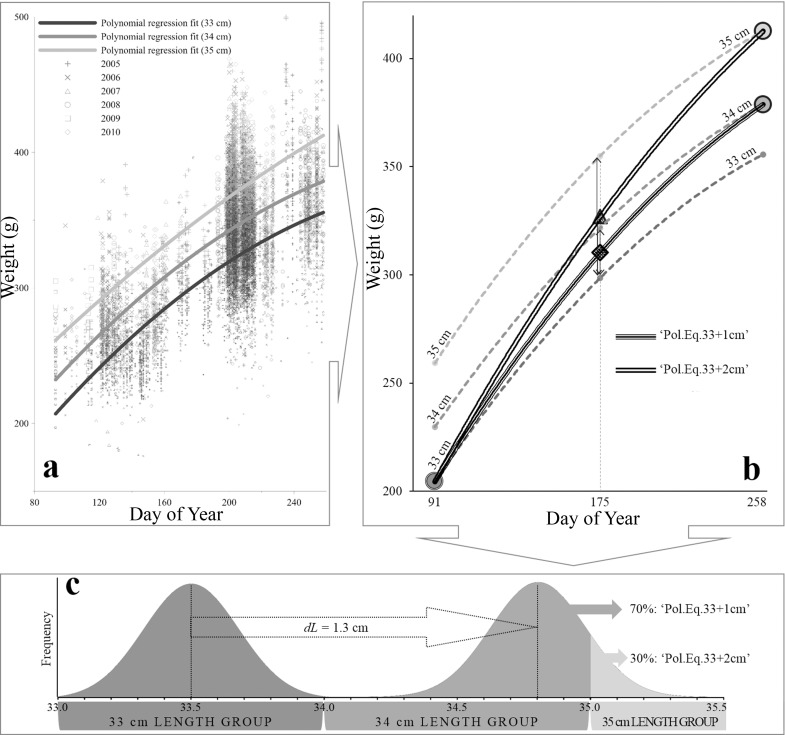
Example of growth correction for length distribution of herring, considering 33 cm length group as reference and a dL value of 1.3 cm (as a result example for Eq 6).Firstly, (a) polynomial equations are fitted for weight (g) increment per day (Day of Year) in 33, 34 and 35 cm length groups. Secondly, (b) considering the beginning of the feeding period (Day of Year = 91, marked as opened circle) as a starting point for the 33 cm length group, and the end of the feeding period (Day of Year = 258) for 34 and 35 cm length groups as ending points (closed circles), new equations are built for each cm growth steps: ‘Pol.Eq.33+1cm’ equation for 33+1 cm and ‘Pol.Eq.33+2cm’ equation for 33+2 cm. The mid-point (Day of Year = 175, marked with rhombus and triangle) in weight estimates for each new equation has the same distance (vertical arrows) from the estimated weight at that day for the lower length group and for the upper length group. Finally, (c) based on the dL and assuming a normal distribution for each cm length group, ‘Pol.Eq.33+1cm’ equation applies to the 70% of the 33 cm herring population abundance that will incorporate to the 34 cm length group one year later, whereas ‘Pol.Eq.33+2cm’ will apply to the other 30% that will correspond the 35 cm length group.